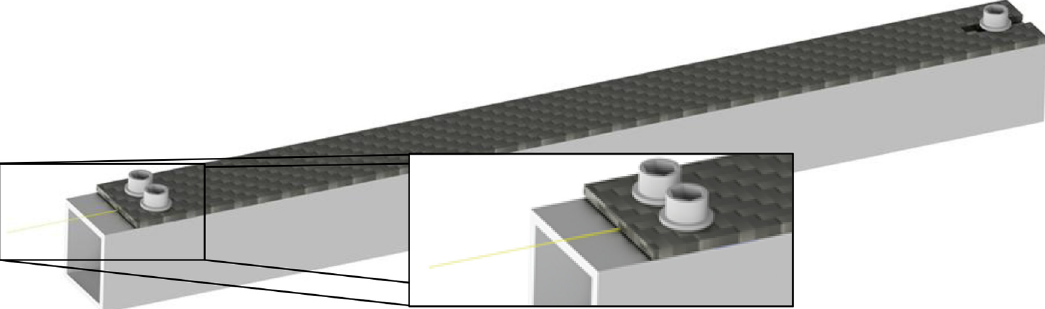
Fig. 1. CAD model of the fi xed